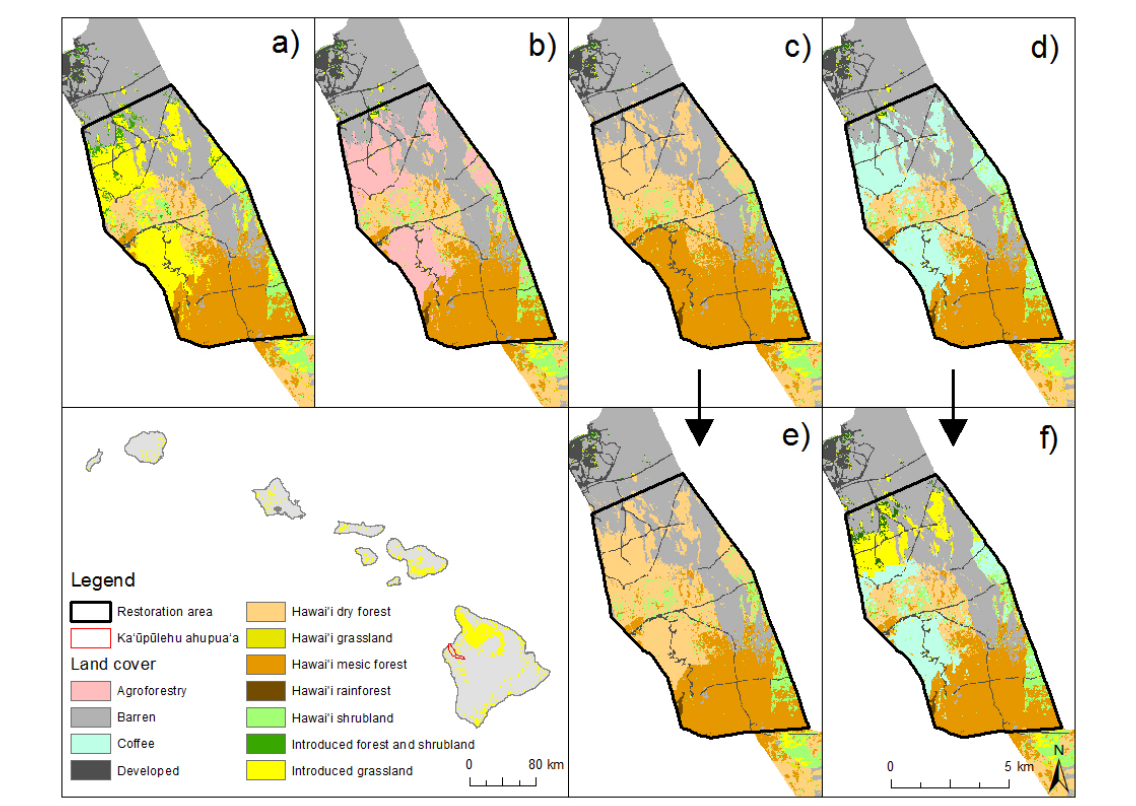
Fig. 1. Land-use scenarios under the current and future climate (RCP 8.5 midcentury) for pasturelands in Ka ʻū p ū lehu ahupua ʻ a. (a) pasture (current and future climate); (b) Hawaiian agroforestry (current and future climate); (c) native forest restoration (current climate); (d) coffee (current climate); (e) native forest restoration (future climate); (f) coffee (future climate). The area suitable for coffee is reduced under climate change given temperature constraints. The type of forest restored (dry vs. mesic) also shifts under climate change with changes in precipitation. Agroforestry and pasture extent and composition do not change within the range of precipitation